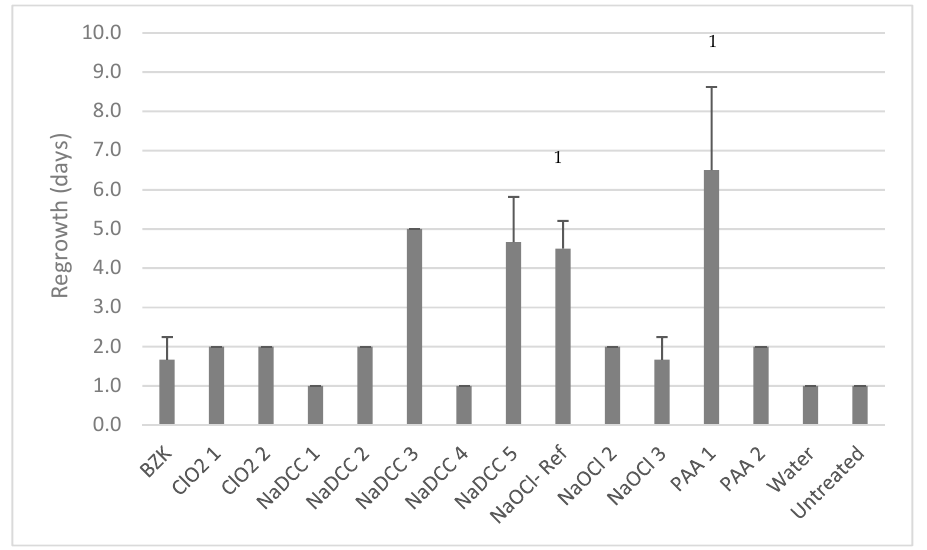
Figure 4. Efficacy of products in preventing regrowth post-wiping. 1: indicates that only two biological replicates were performed.